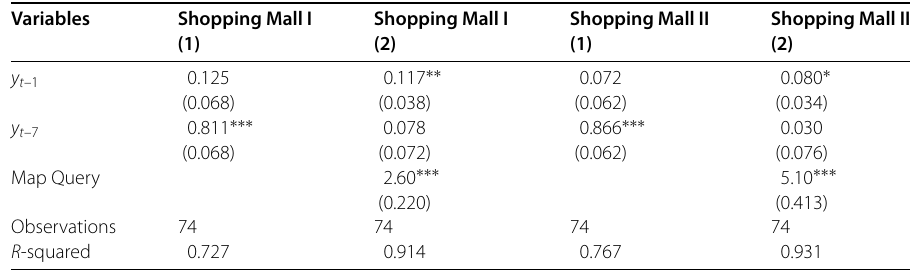
Table 1 Regressions of foot traffic and map queries